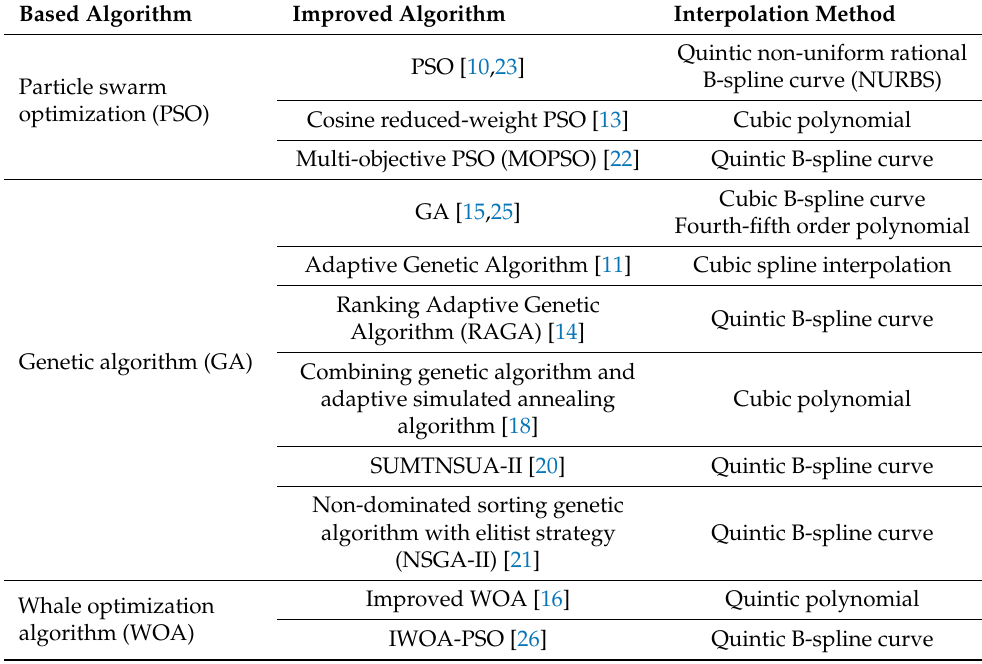
Table 1. Commonly used trajectory optimization